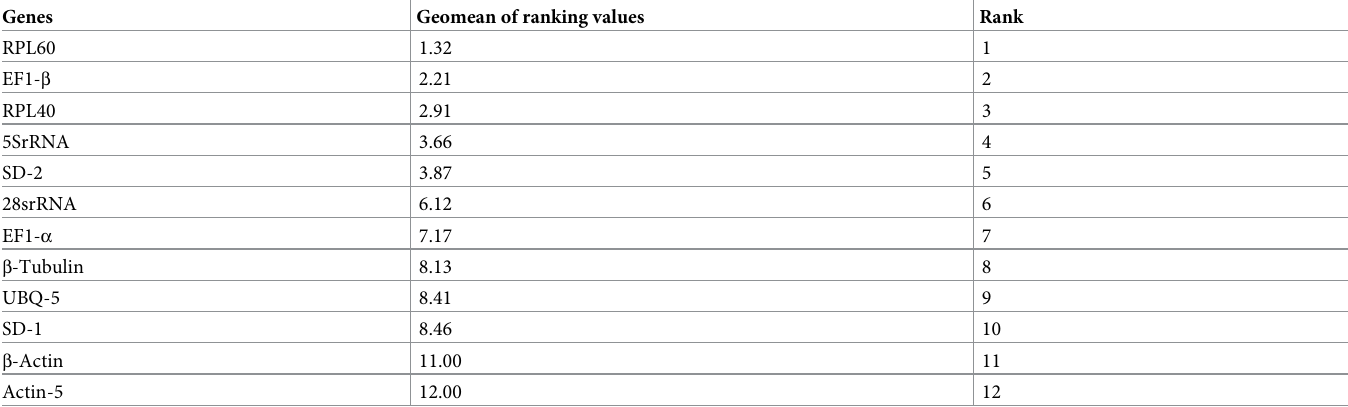
Table 4. RefFinder ranking of the 12 candidate reference genes with respect to their expression stability under different experimental conditions.